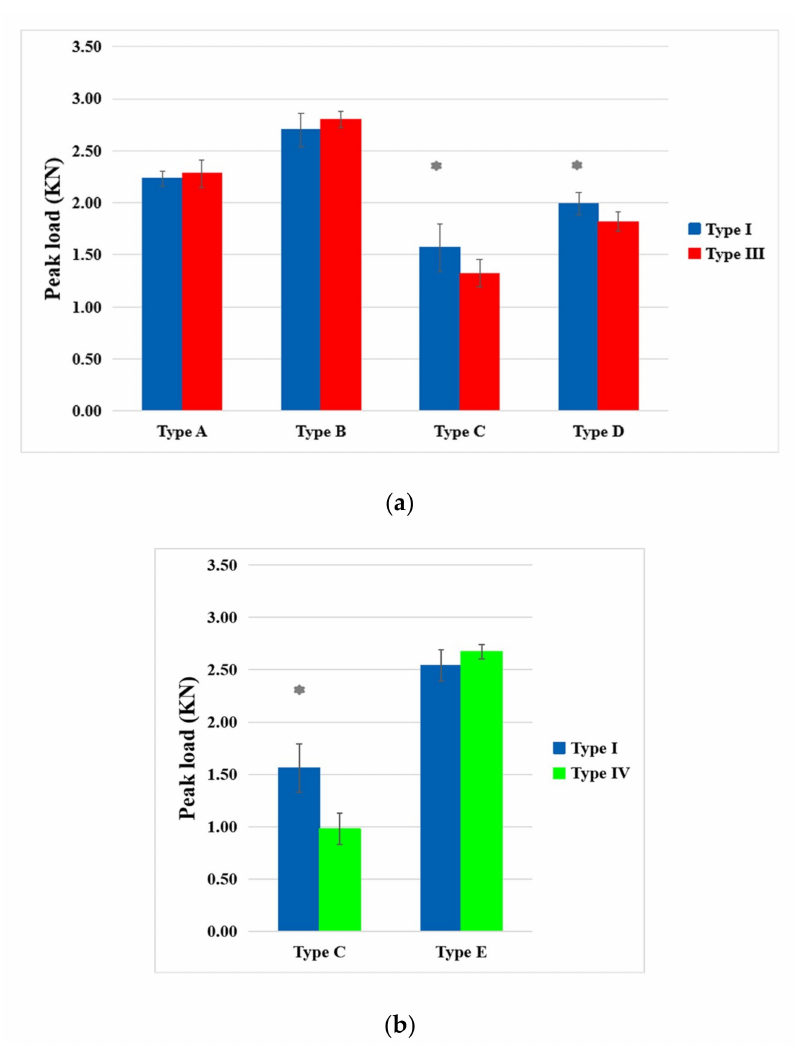
Figure 6. Comparison of the pullout test results; the error bar shows standard deviation, and the blocks indicate mean values. ( a ) Comparison between Type I and III screws in Type A, B, C and D bone specimens ( p = 0.471, p = 0.106, p = 0.046 and p = 0.031, respectively), and ( b ) comparison between Type I and Type IV screws in Type C and E bone specimens ( p = 0.006 and p = 0.105, respectively). * Significant di ff